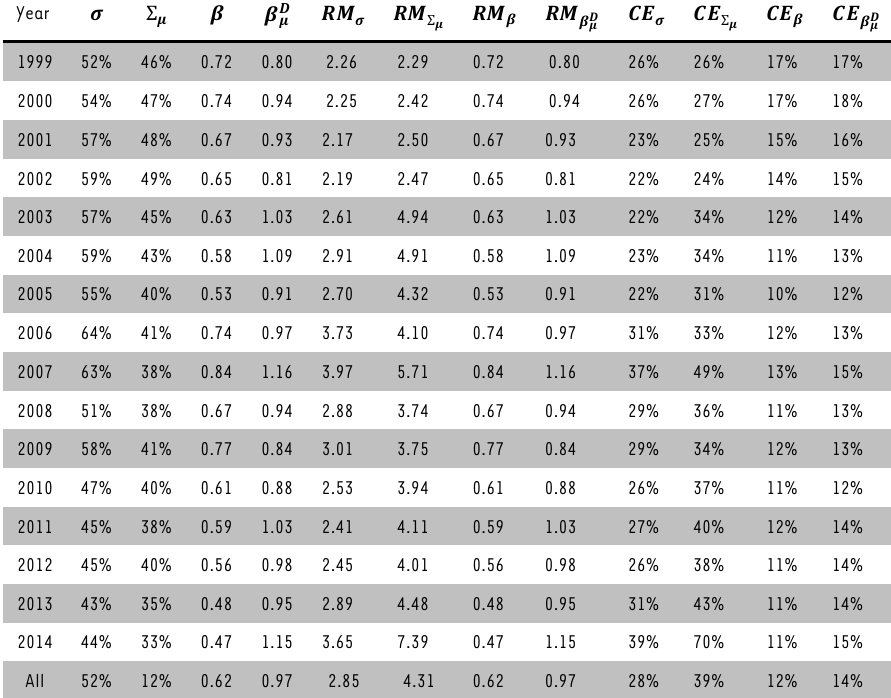
TABLE 6: Risk measures and cost of